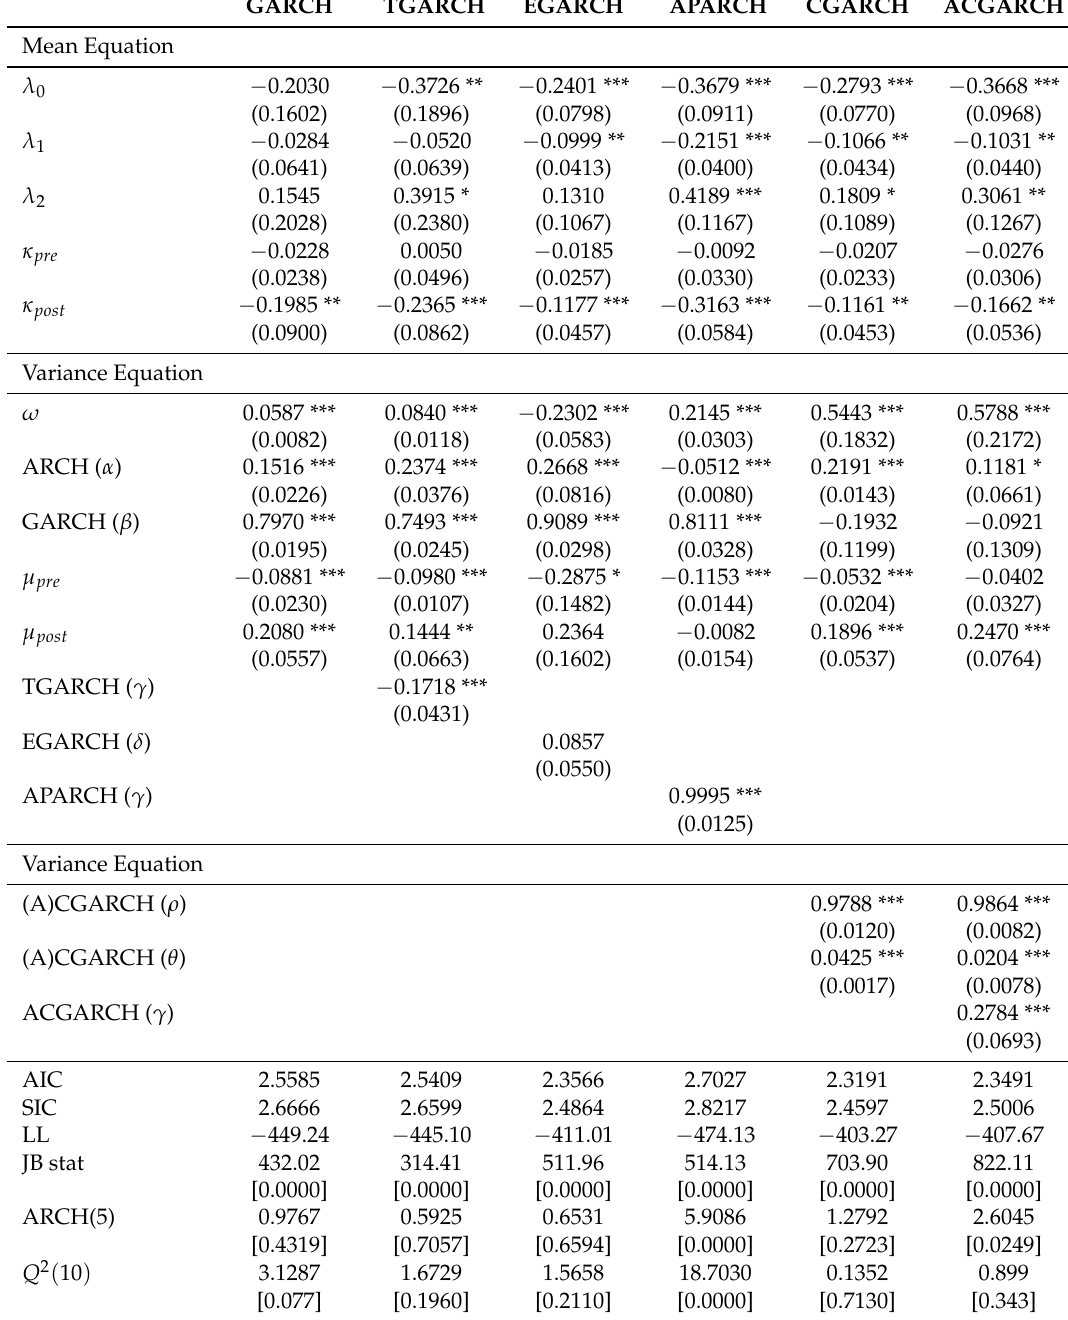
Table A6. GARCH-M Tests for Ripple for the sample of 360